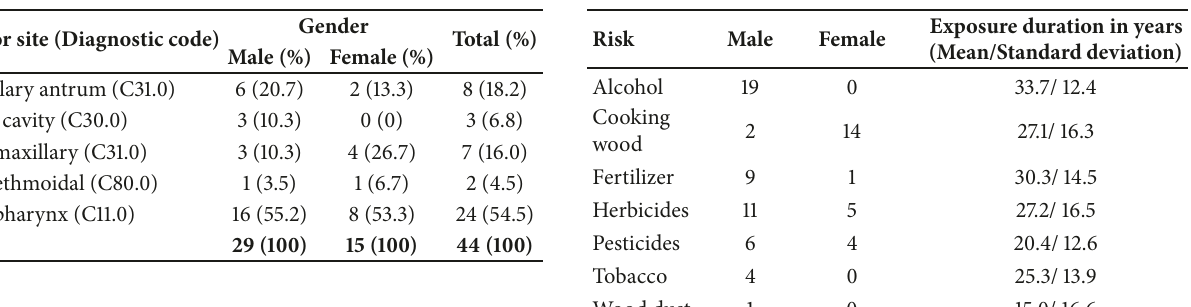
Table 2: Tumor site distribution by gender. Table 3: Risk exposures by